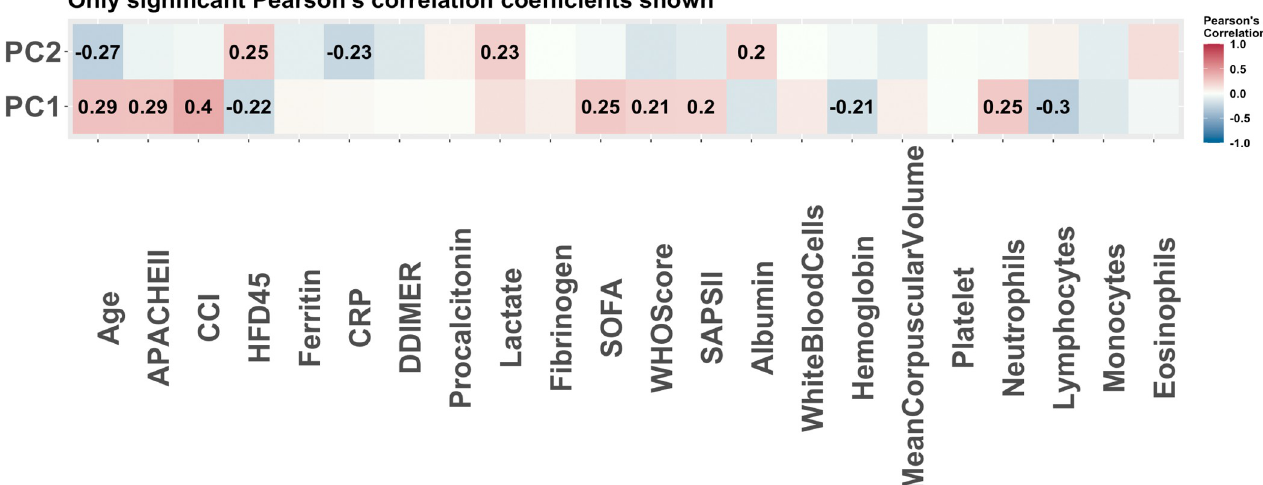
Table 7. Regression models for proteins associated with COVID-19 status. Pathway (intercept) PC1 PC2 Age Gender Cholesterol metabolism, Ovarian steroidogenesis, Vitamin digestion and absorption, Fat digestion and absorption